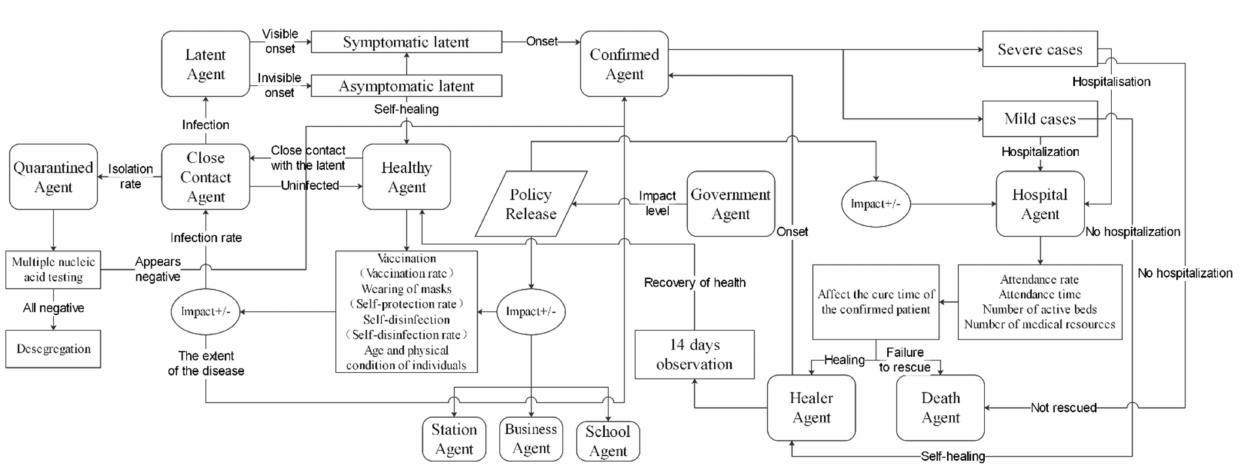
Figure 2. Resident agent state transition